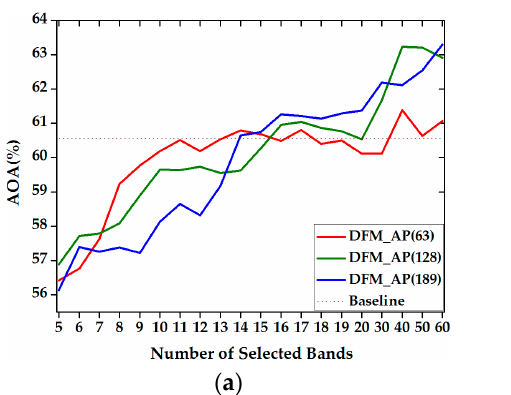
Table 3. AOA of the proposed DFM-AP compared to the number of negative constraints with different numbers of selected bands (NB) for the Indian Pines and Xuzhou datasets. Dataset AOA NB